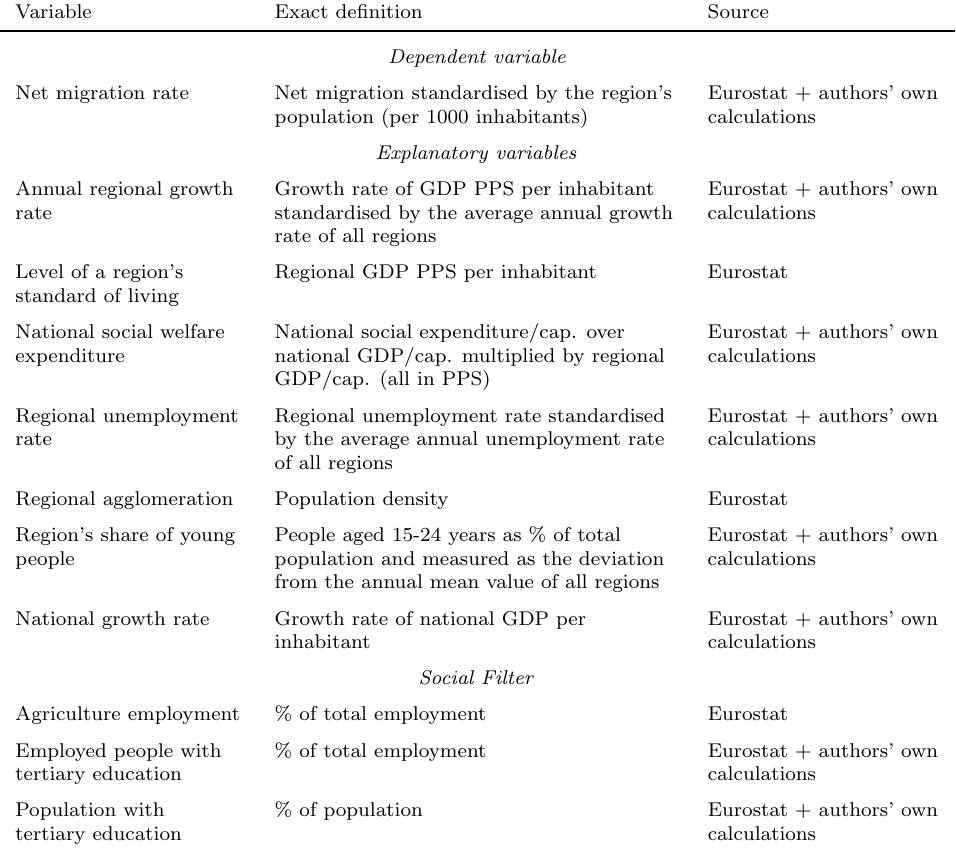
Table A.1: Data sources and exact definition of the